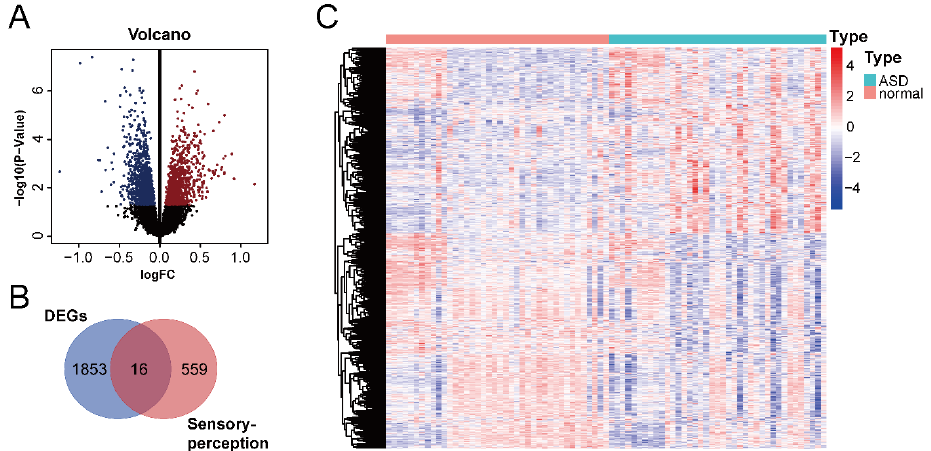
Figure 2. Data correction. ( A ) Box plot before data correction. ( B ) Box plot after data correction.